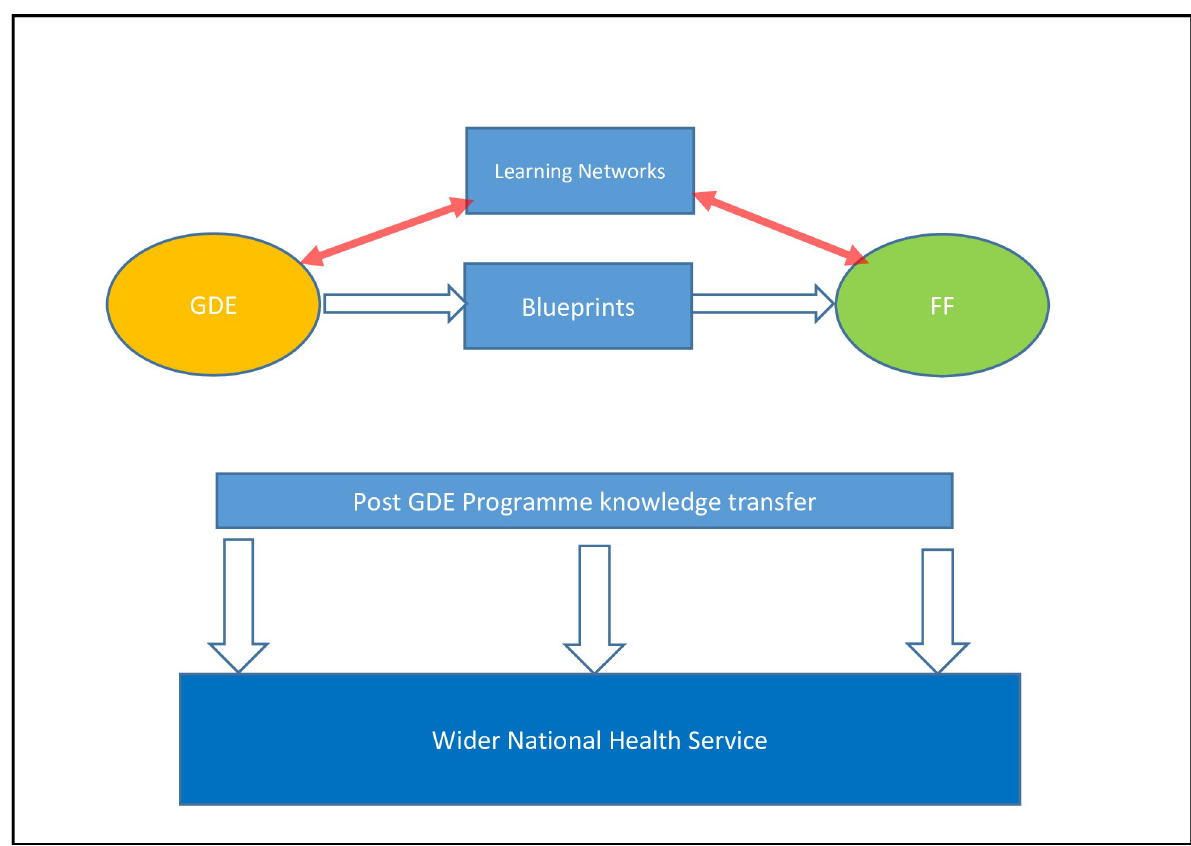
Fig 1. Intended mechanisms of knowledge transfer between GDEs and FFs and to the wider